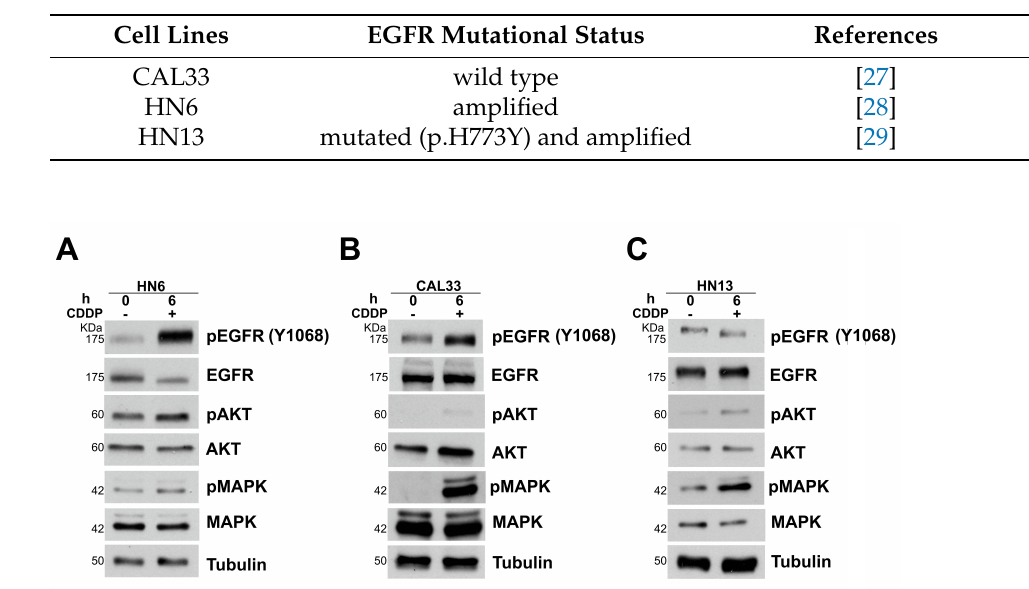
Table 1. EGFR mutational status in CAL33, HN6, and HN13 HNSCC cells.